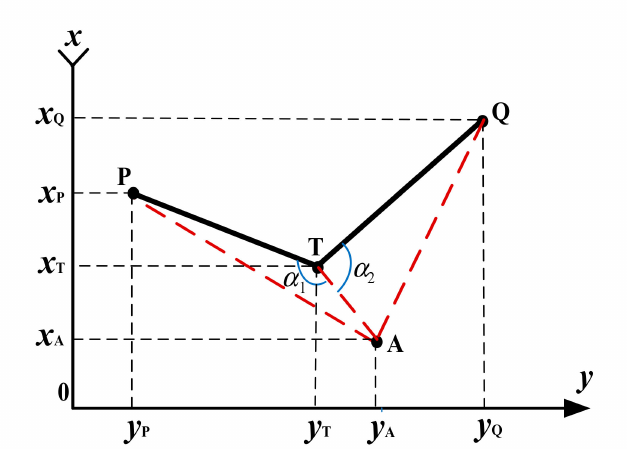
Figure 6. Downward-convex option of flood zone